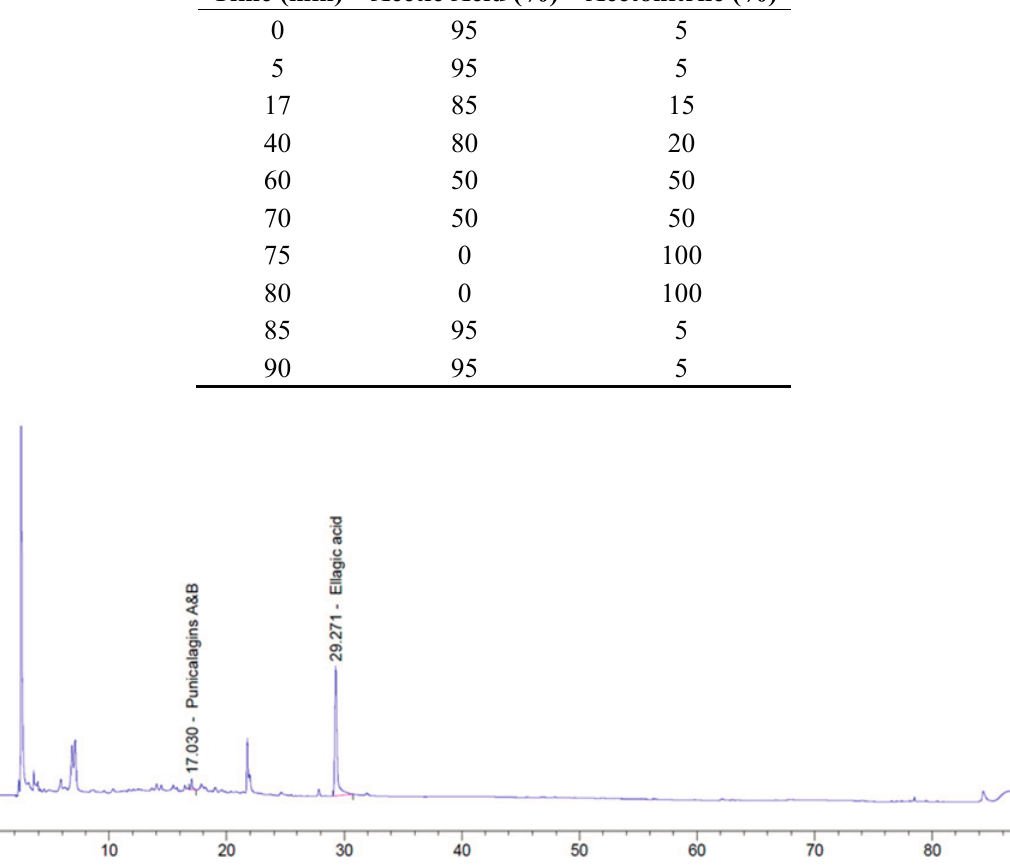
Figure 10. HPLC chromatogram of pomegranate concentrate powder. Peaks represent total punicalagins and ellagic